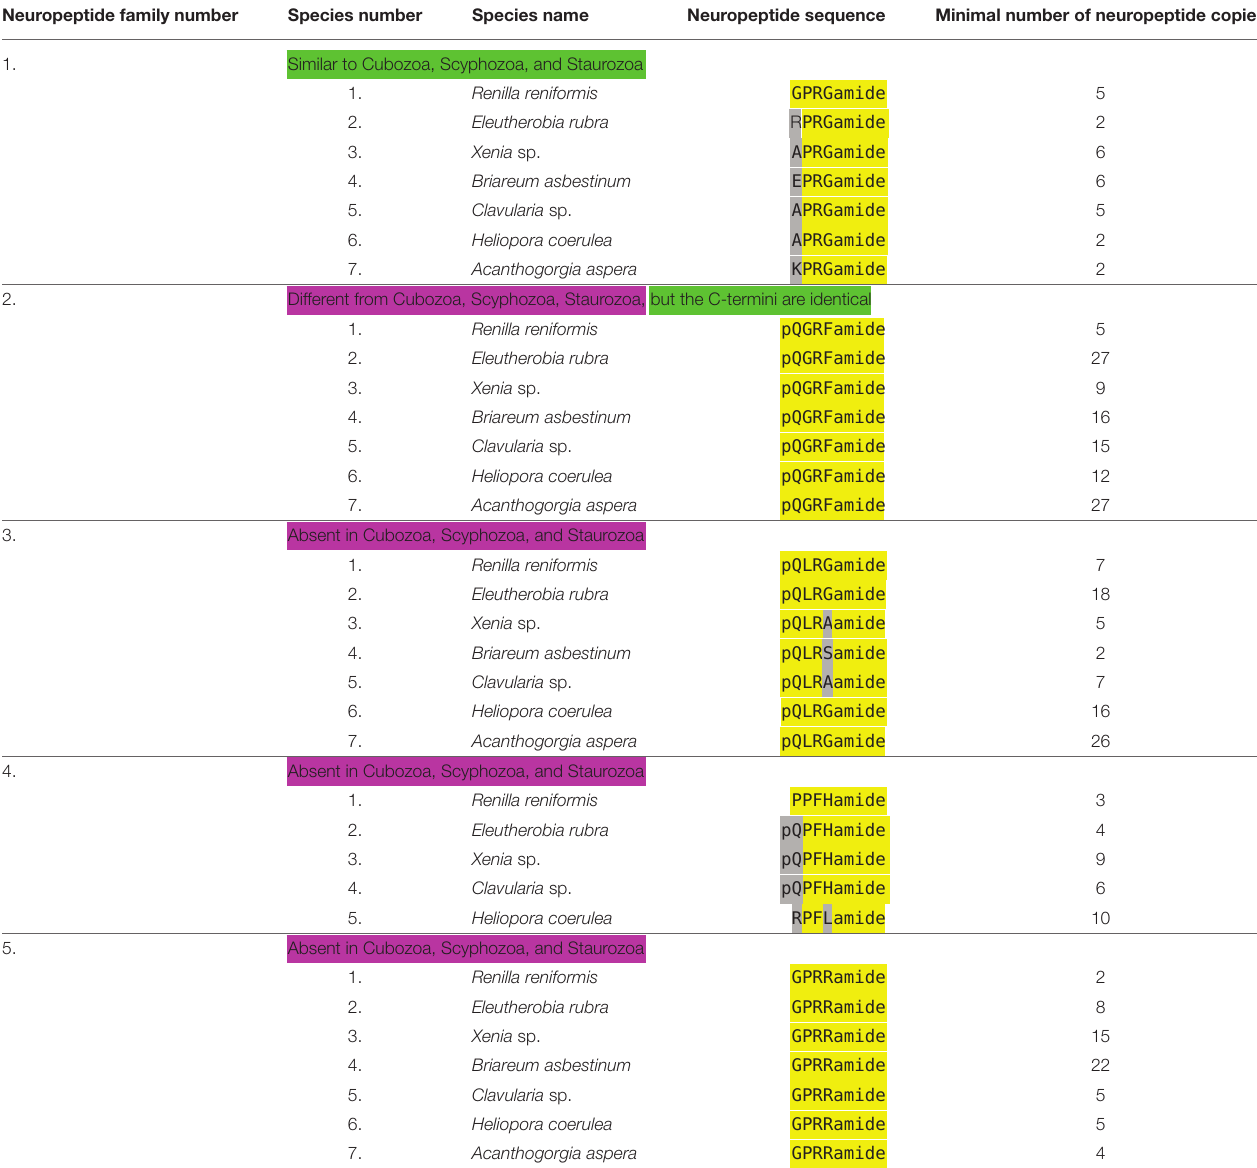
TABLE 5 | An overview of octocorallian neuropeptide families. Neuropeptide family number